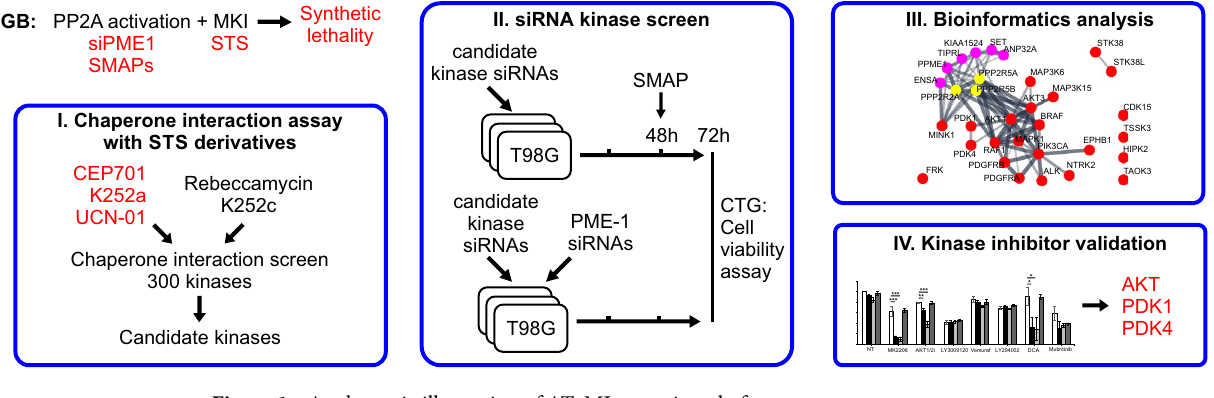
Figure 1. A schematic illustration of AToMI screening